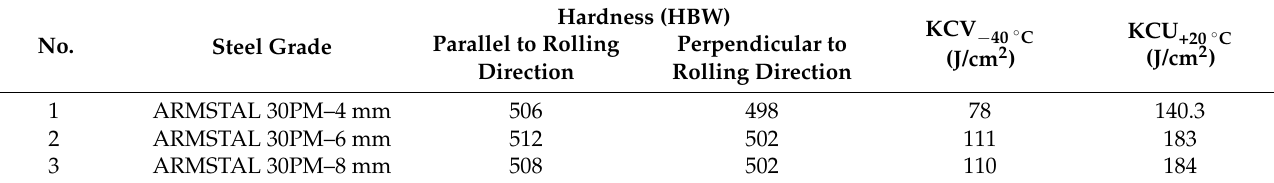
Figure 5. Geometry of the samples during impact strength tests ( a ) V-notch shape; ( b ) U-notch shape. Table 3. The results of ARMSTAL 30PM hardness measurements and impact strength